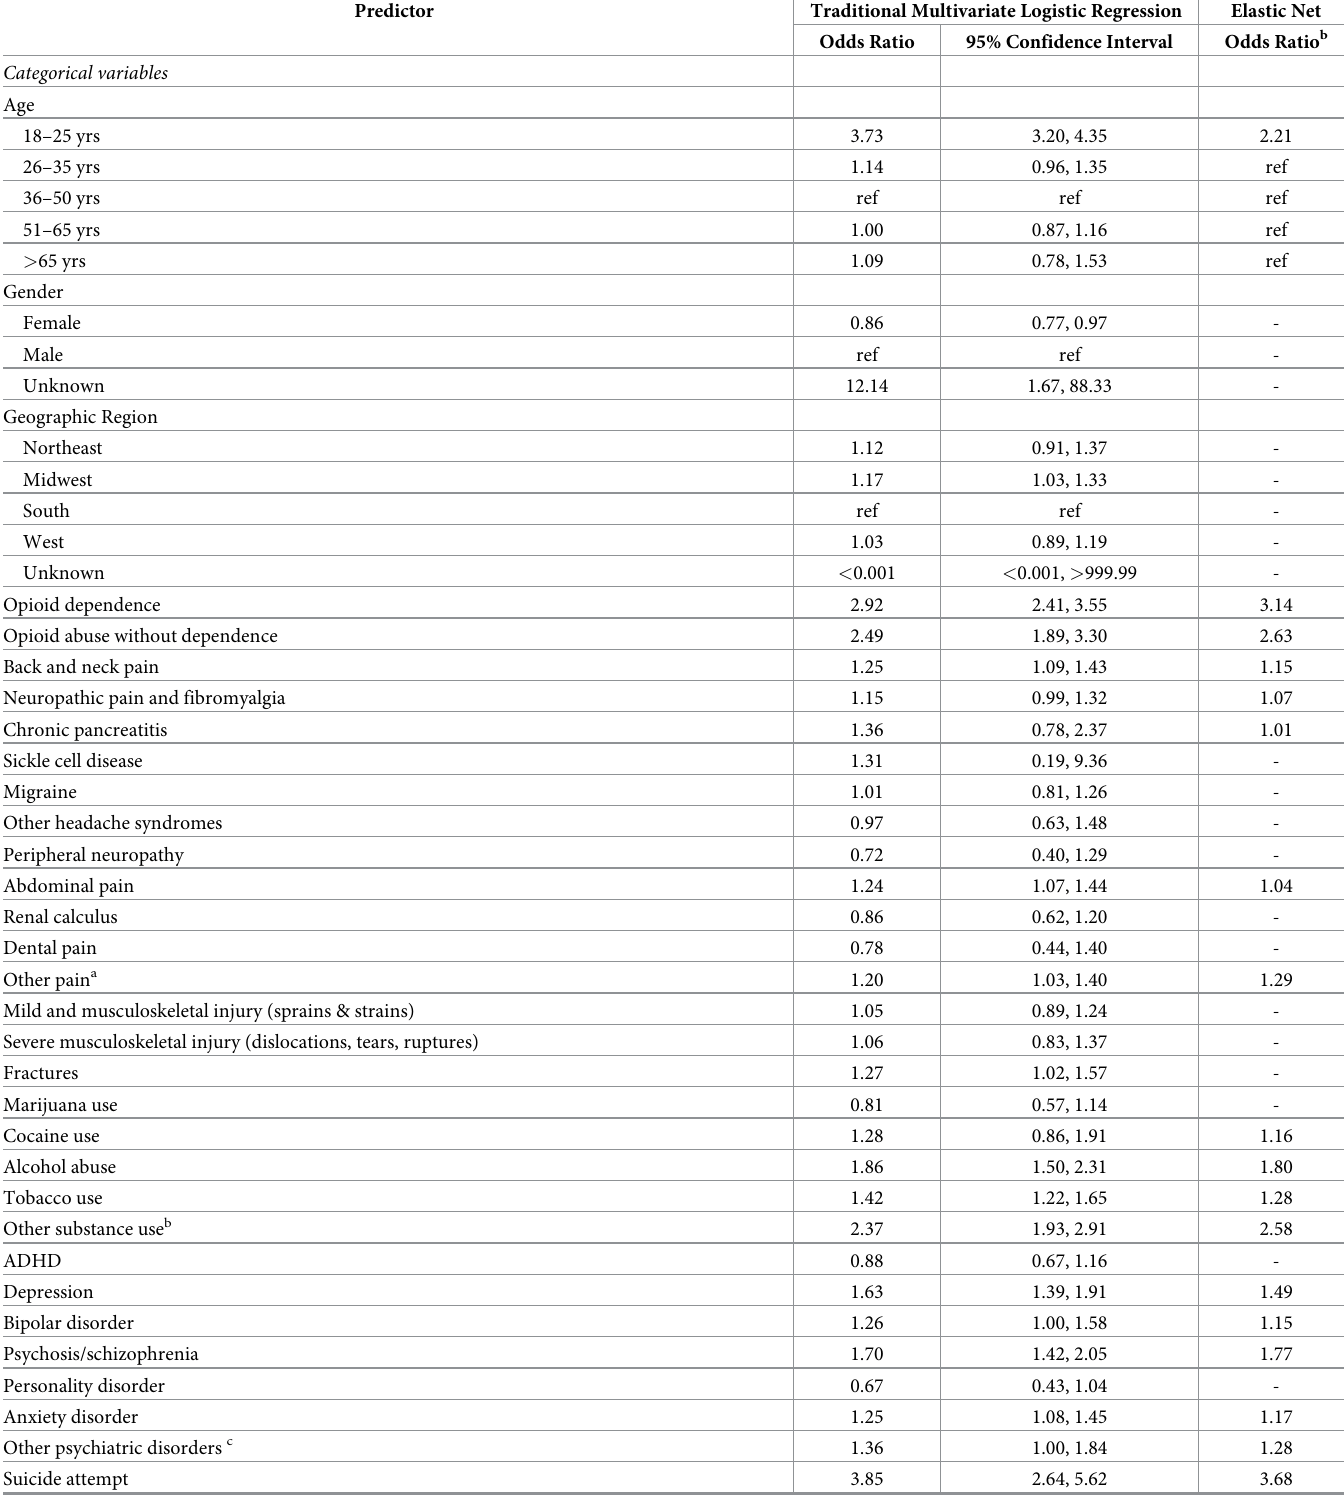
Table 3. Model coefficients for the traditional multivariate logistic regression model and the elastic net